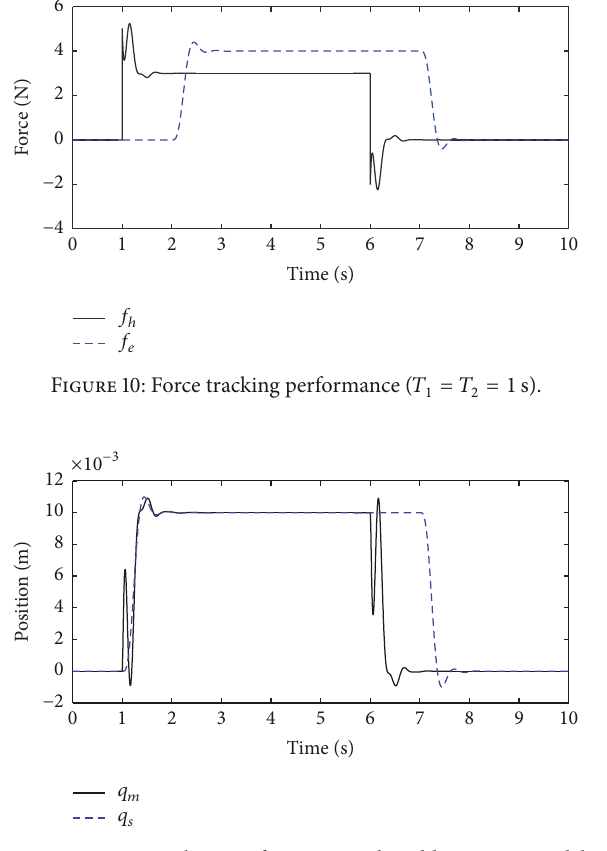
Figure 11: Position tracking performance with sudden appearing delays.